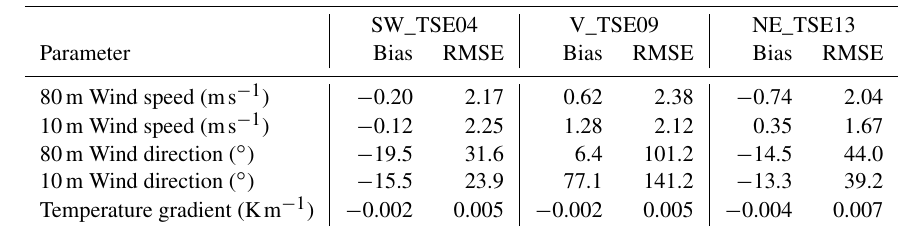
Figure 10. Comparison between meteorological tower data and WRF–LES–GAD d05 for 80m wind speed (a–c) , 80m wind direction (d–f) , and 100–10m temperature gradient (g–i) for the convective case study. SW_TSE04 and NE_TSE13 are located on ridges, while V_TSE09 is located in the valley. Note that the model wind speed and direction are output at 10s intervals, while the temperature is output every 150s. Table 3. Wind speed, wind direction, and temperature gradient bias and RMSE between WRF–LES–GAD and meteorological tower mea- surements for the convective case study.